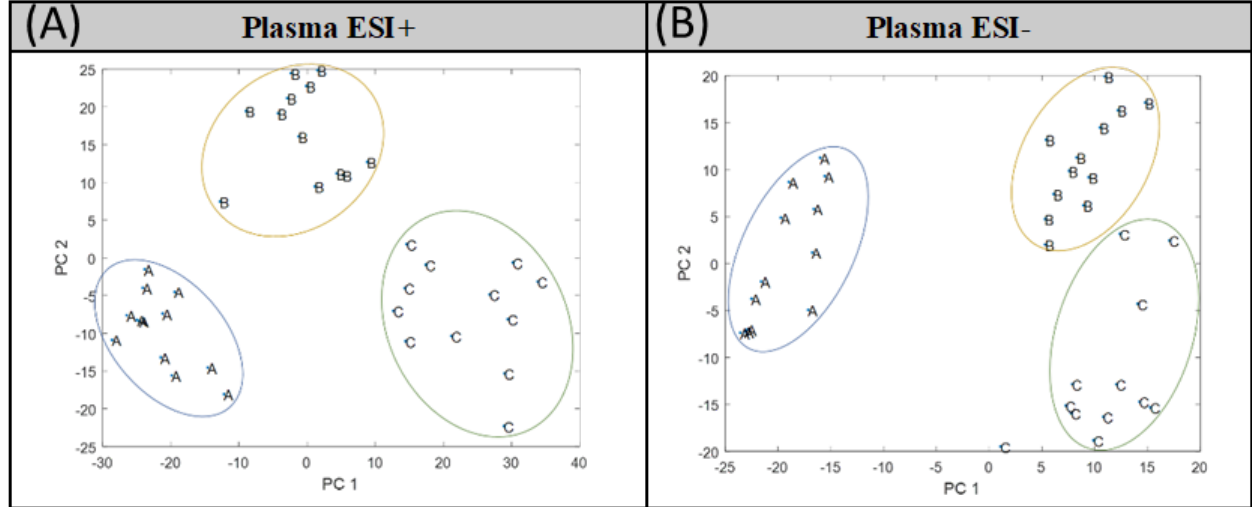
Figure 2. PLS-DA score plots obtained for ( A ) Plasma ESI+ and ( B ) Plasma ESI − matrices. Piglet groups: newborns (A), infants (B), and children (C).